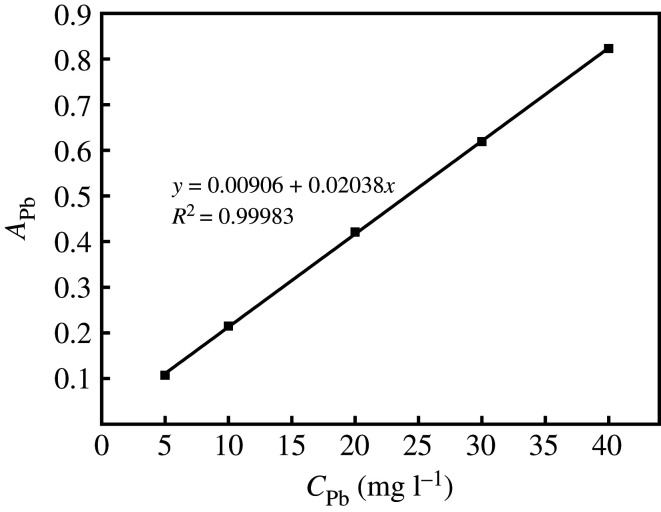
Standard curve for determining Pb2+ content.